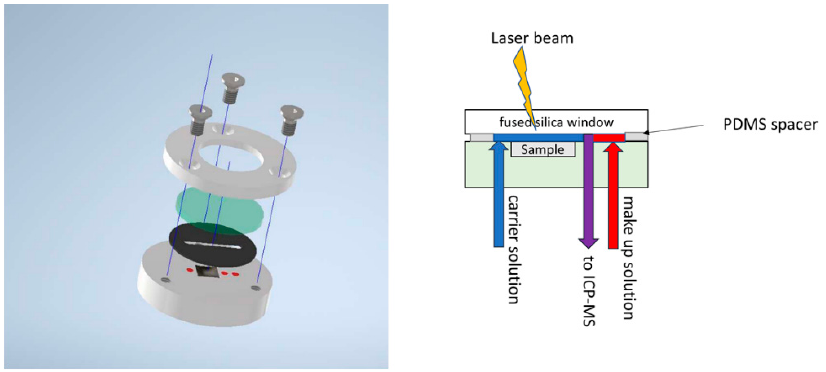
Figure 5. Left: CAD exploded drawing of the LASIL cell. The gray parts represent PEEK, the PFA tubing pushed in the PEEK body is depicted in red, the PDMS spacer in black, and the fused silica window in green. Right: Cross-section of the LASIL cell showing the fluid path and the flows through the sample cell. The LASIL cells consisted of a PEEK body with a cavity for the sample.